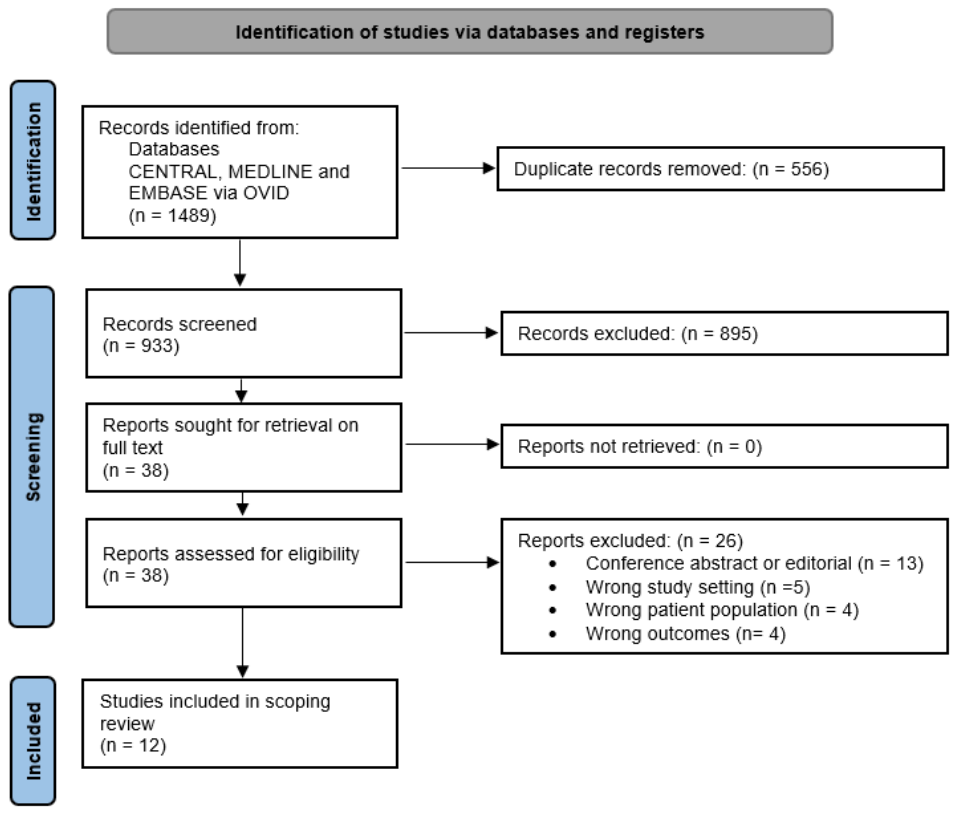
Figure 1. PRISMA Flow Diagram.